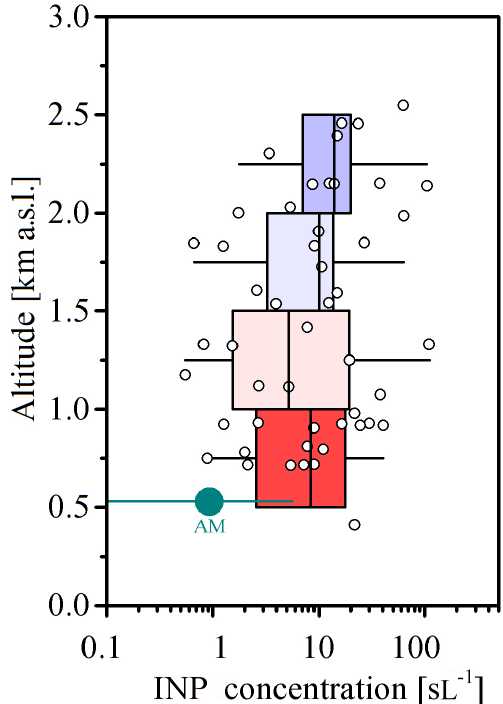
Figure 11. INP concentrations ( T =− 30 ◦ C; RH ice = 135.4%, cir- cles) versus sampling altitude. The boxes (colors same as Fig. 10) show the interquartile range of the data with the median given as a vertical solid line, the black bars give the full range of concentra- tions. The median INP concentration of 33 FRIDGE measurements from this campaign at CAO in Agia Marina (AM; 532ma.s.l.) is indicated by a the cyan circle; the range is shown by a cyan